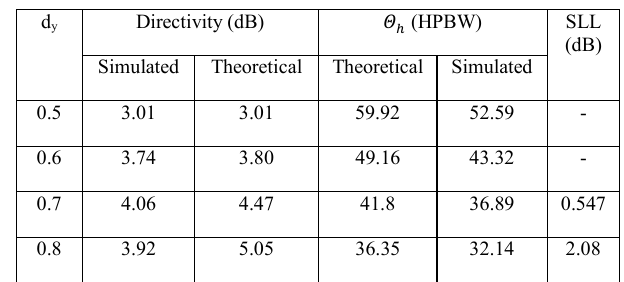
Table 8 Linear antenna array (N = 2 , βy = 0°)